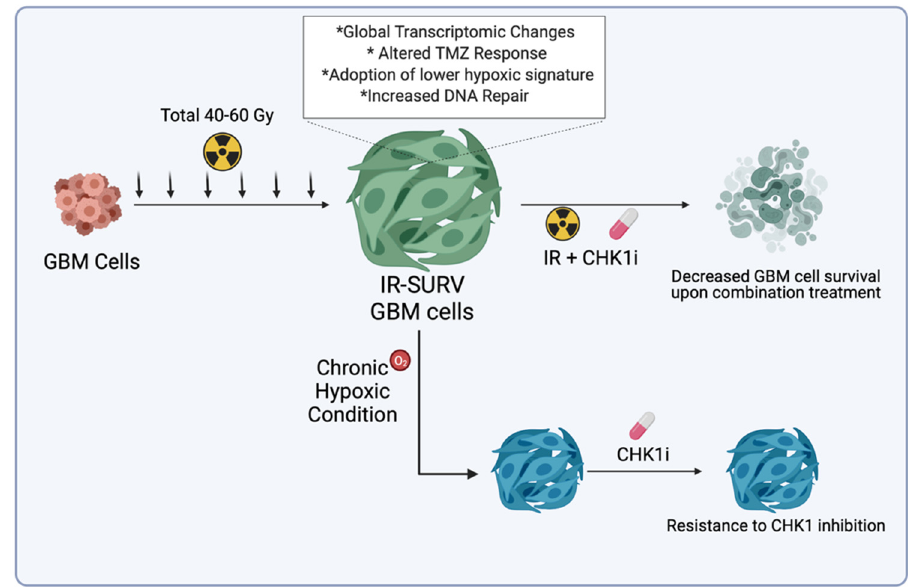
Figure 7. Graphical abstract of the study.